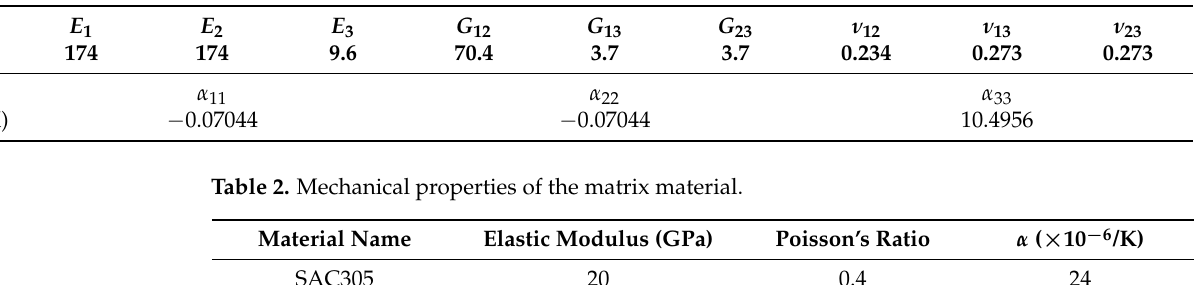
Table 1. Material properties of reinforced fibers.